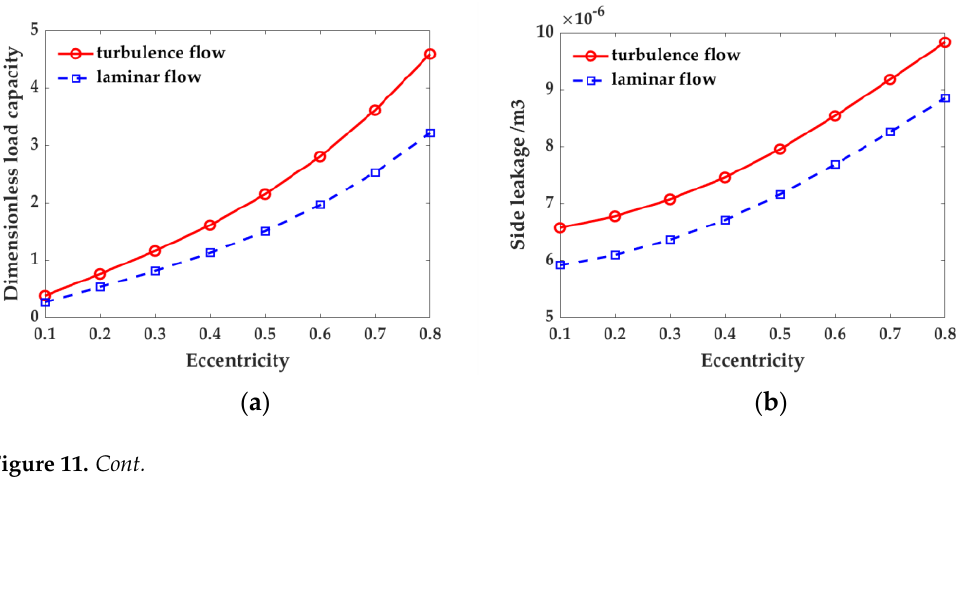
( d ) Figure 11. Performance comparison between the turbulence flow state and the laminar flow state. ( a ) Dimensionless load capacity ( b ) Side leakage ( c ) Dimensionless friction power ( d ) Average temperature rise. 3.2. Comparison of Cartesian Coordinate System and Oblique Coordinate System Figure 12 below shows the oil film thickness diagram and pressure distribution diagram of the constant-width HGJBs calculated using the Cartesian coordinate system and the oblique coordinate system when the eccentricity is 0.4, where Figure 12a,b are the calculation results using the Cartesian coordinate system, and Figure 12c,d are the calculation results using the oblique coordinate system: